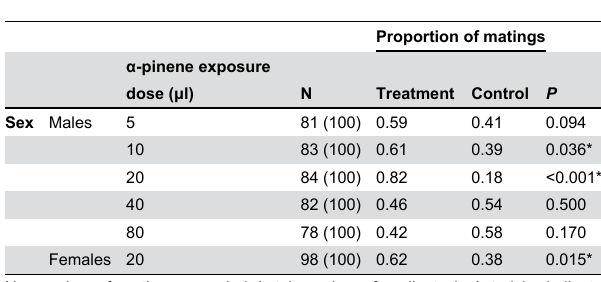
Table 1. Mating rates of olive fruit fly adults exposed to α- pinene (treatment) or maintained non exposed to any compound